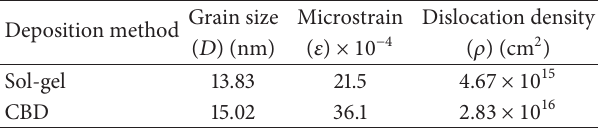
Table 1: Structural parameters of the CuO